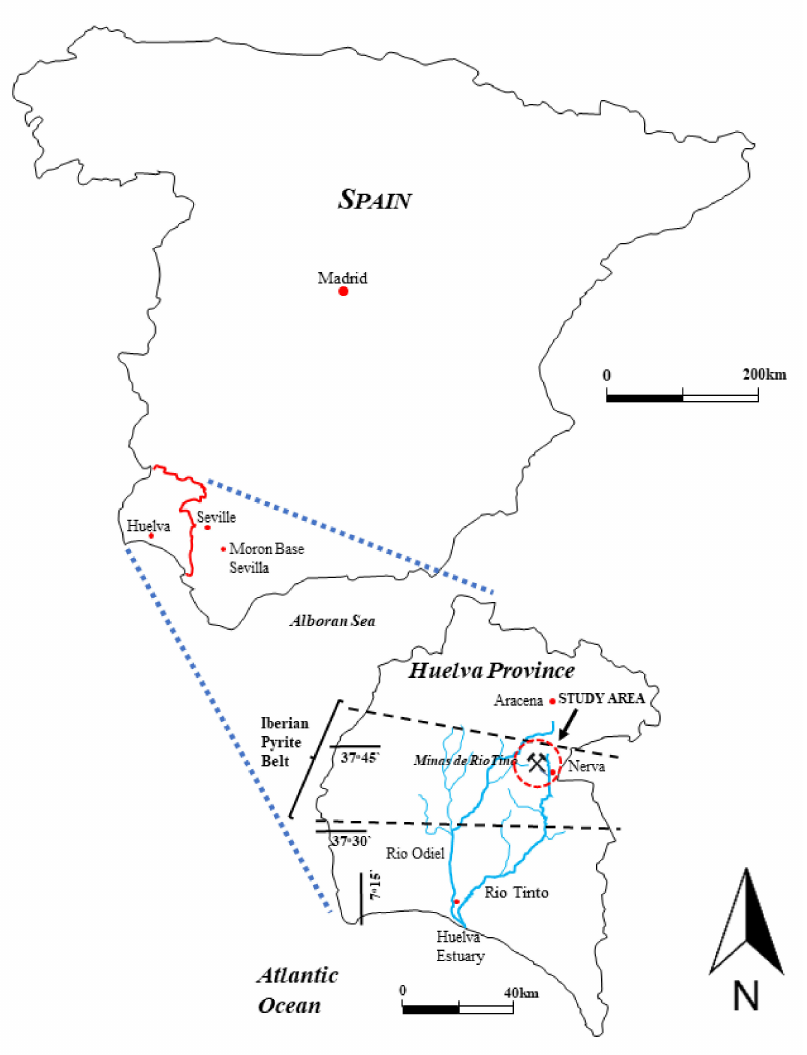
Figure 1. Schematic map displaying the geographical location of the study area, highlighting the hydrogeology of the Rio Tinto and Rio Odiel, including the outline of the Iberian Pyrite